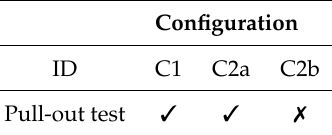
Table 5. Performed pull-out tests.